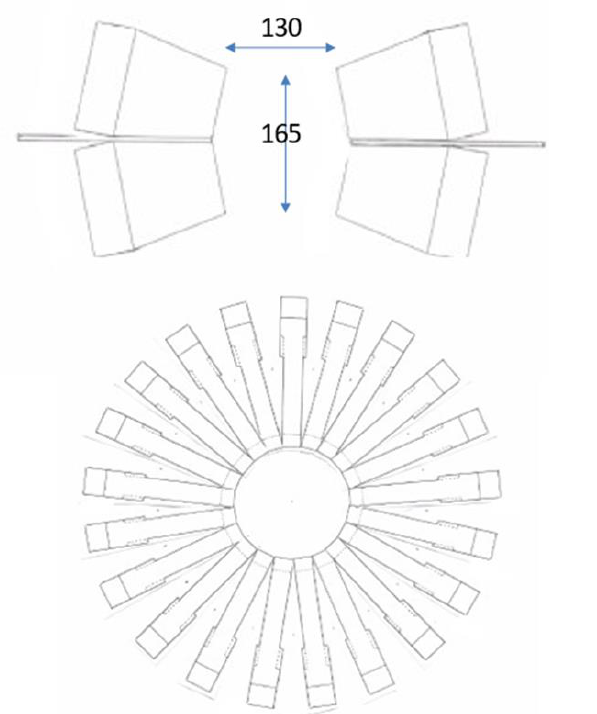
Figure 3. MicroPET cassette as used in constructing MicroPEPT: the four LSO crystals on the left of the picture are connected via light guides to position sensitive PSDs on the right.